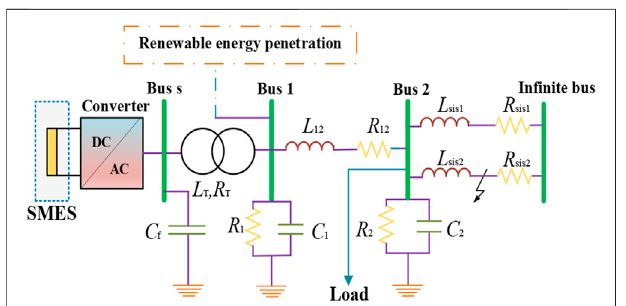
FIGURE 7 | The con fi guration of an SMES system in a